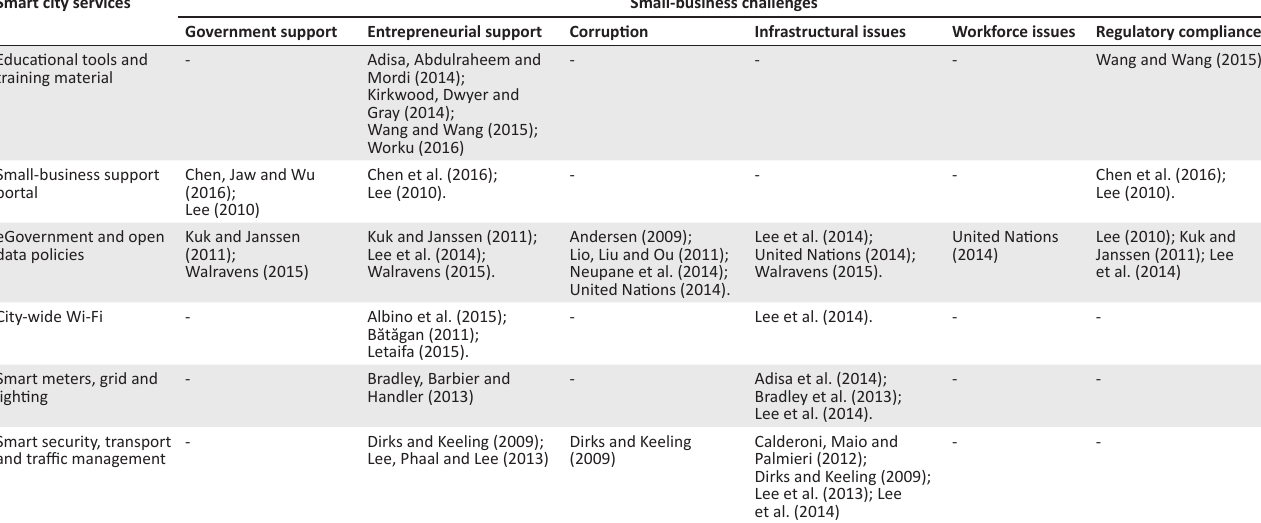
TABLE 2: Mapping of small-business challenges to smart city